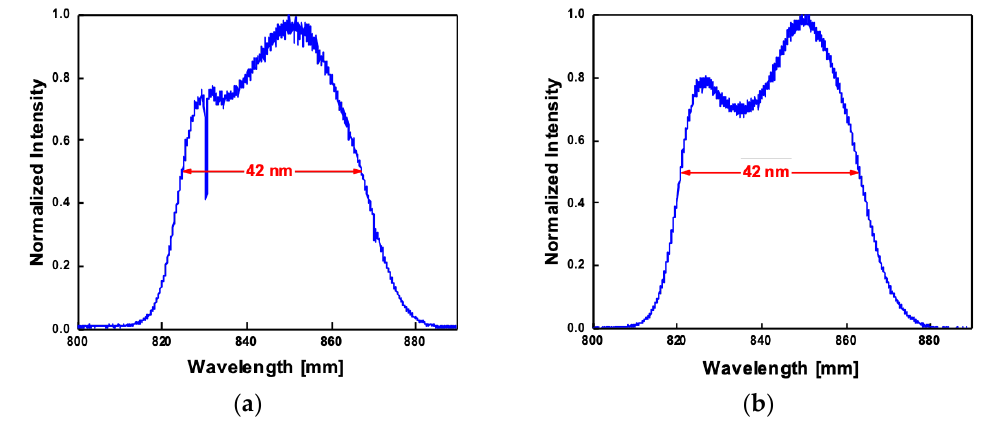
Figure 7. Spectrum measured by ( a ) the S-ADL, and ( b ) the S-TFL.